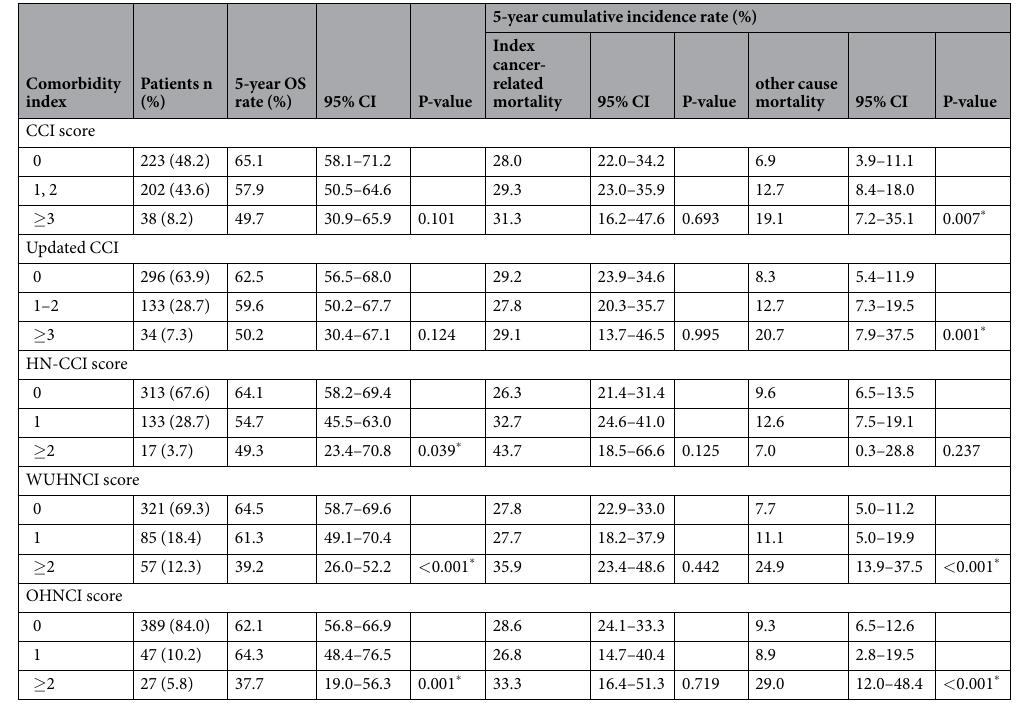
Table 5. Relationship between different comorbidity indices and overall survival (OS) in the external validation set. * P < 0.05. CCI, Charlson comorbidity index; HN, head and neck; OHNCI, Osaka head and neck comorbidity index; WUHNCI, Washington University head and neck comorbidity